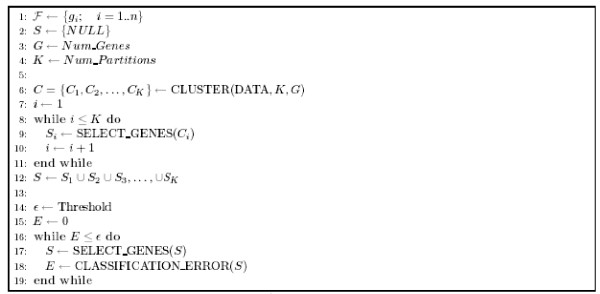
Optimal Feature Set Selection Algorithm. The function CLUSTER uses the k-means clustering approach to partition the initial gene set into the desired number of partitions K, with G genes in each partition. K and G are user-specified. The function SELECT_GENES uses either the greedy approach (Figure 7) or the heuristic simulated annealing approach to solve Problem 2. The function CLASSIFICATION_ERROR uses kNN classification method to assess the discriminant power of the selected genes and returns the classification error.